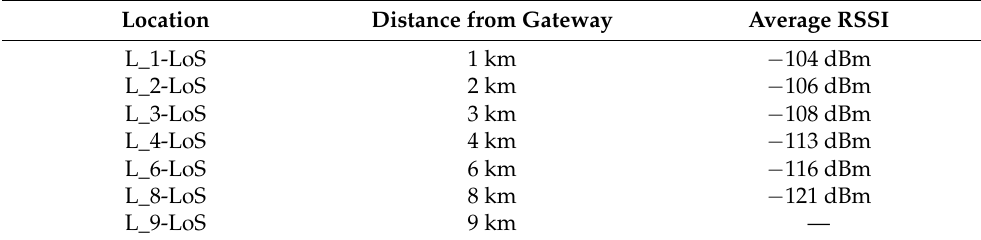
Table 4. RSSI average values obtained for LoS locations.